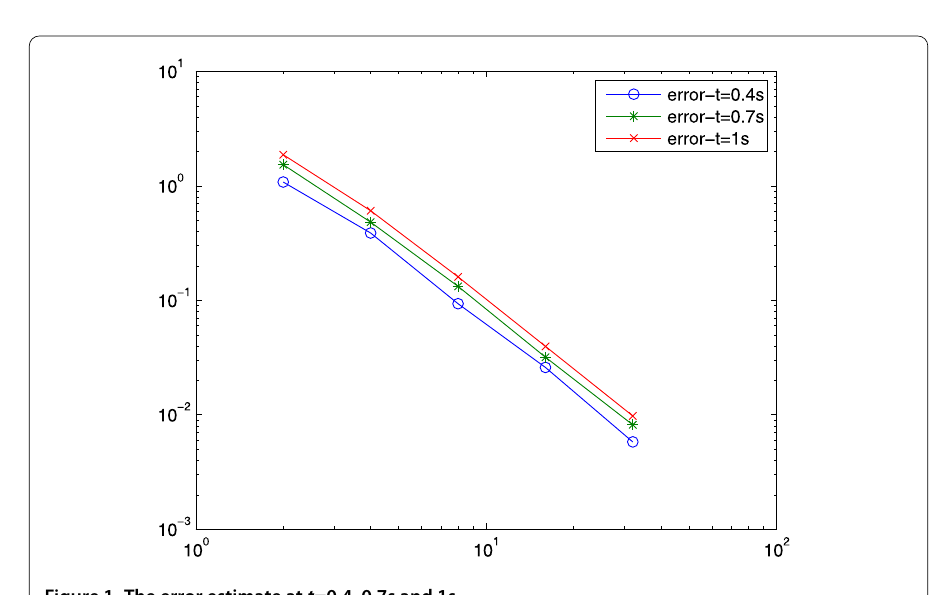
The curve of the error estimate at t = . s ,. s ,. s is drawn in Figure . The following graphics describe the discrete solution u h and the real solution u at t =  s